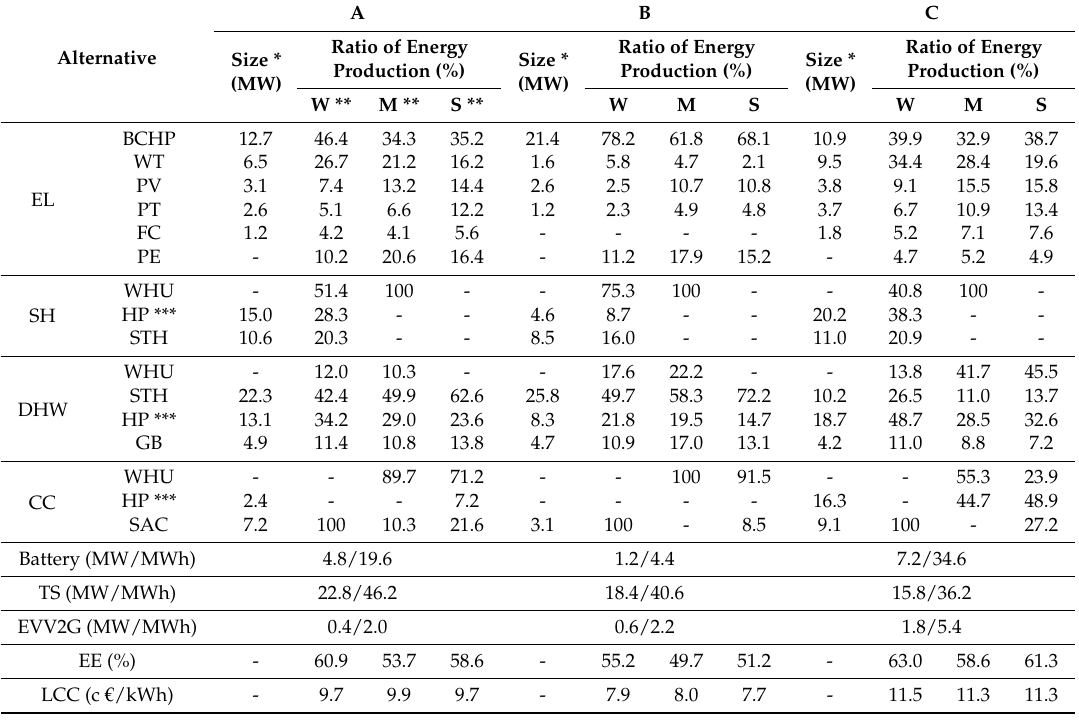
Table 4. Basic optimal MENR system scenarios in Xizhou